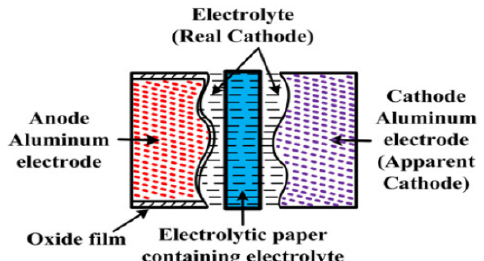
Figure 2. Structure of an aluminum electrolytic capacitor.